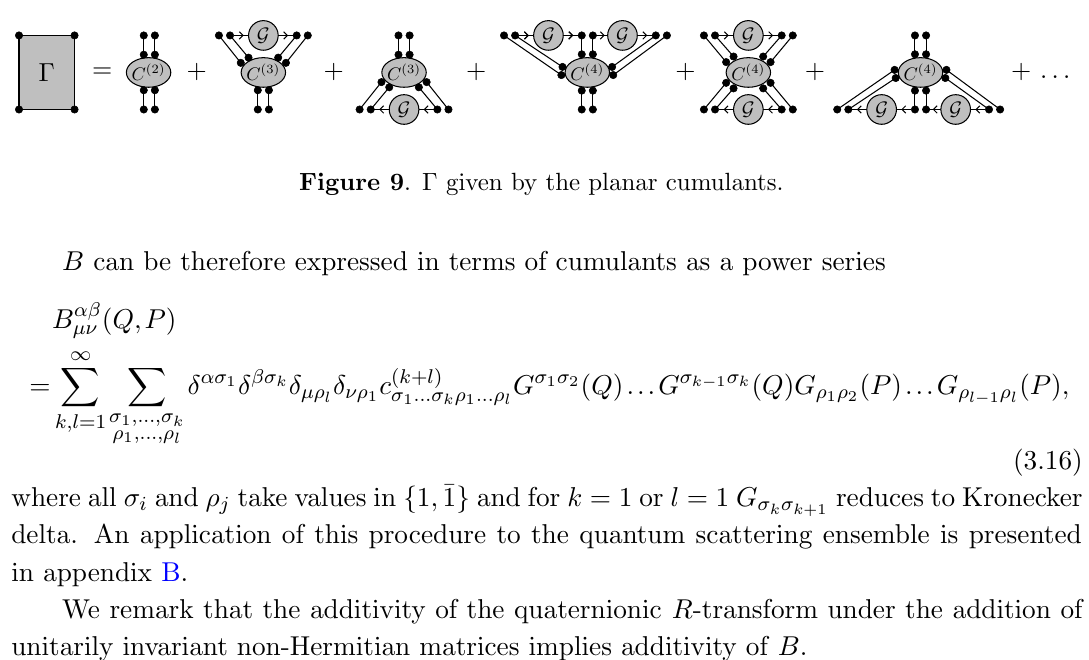
Figure 8 . An example of a diagram contributing to (cid:0). It contributes to the second-to-last diagram in (cid:12)gure 9. Since the matrix indices follow the solid lines and propagators are given by Kronecker deltas, (cid:0) (cid:11)(cid:12);ij = 1 B (cid:11)(cid:12) (cid:14) i (cid:14) j , allowing for the calculation of K . (cid:22)(cid:23) k (cid:22)(cid:23);kl l N